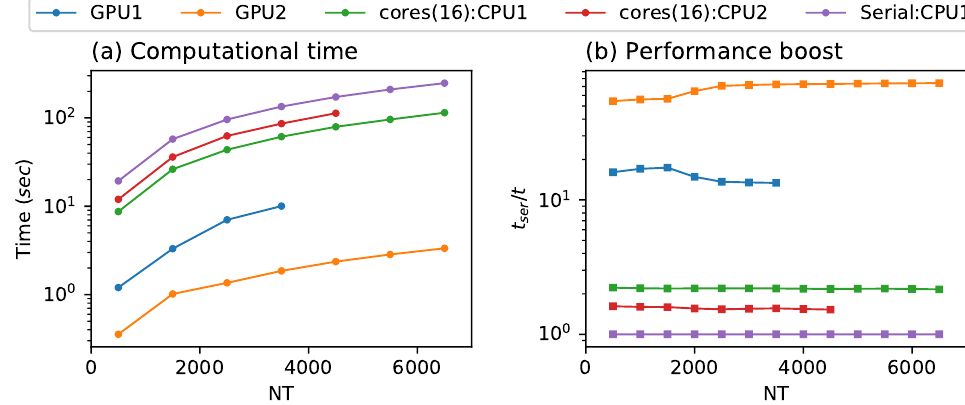
Figure 18. Comparison of computational time and performance for variation of temporal grid size NT keeping spatial grid size constant ( NX = 201, NZ = 401) in forward simulations.